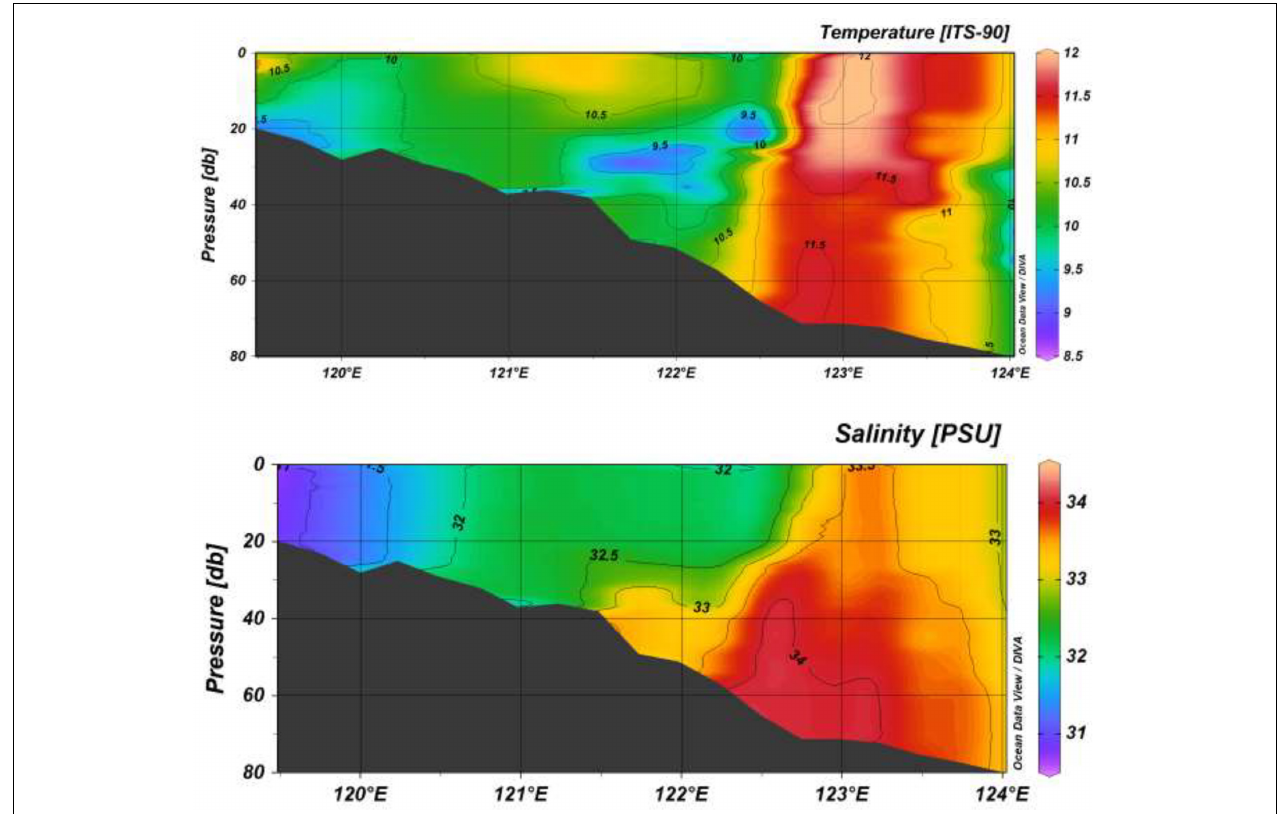
FIGURE 3 | Temperature and salinity distributions in the 35 ◦ N section of the southern Yellow Sea in January 2007 (the section was measured between April 13 and April 15, 2007).